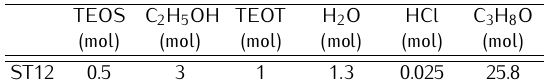
Table 1. Chemical composition of the sol